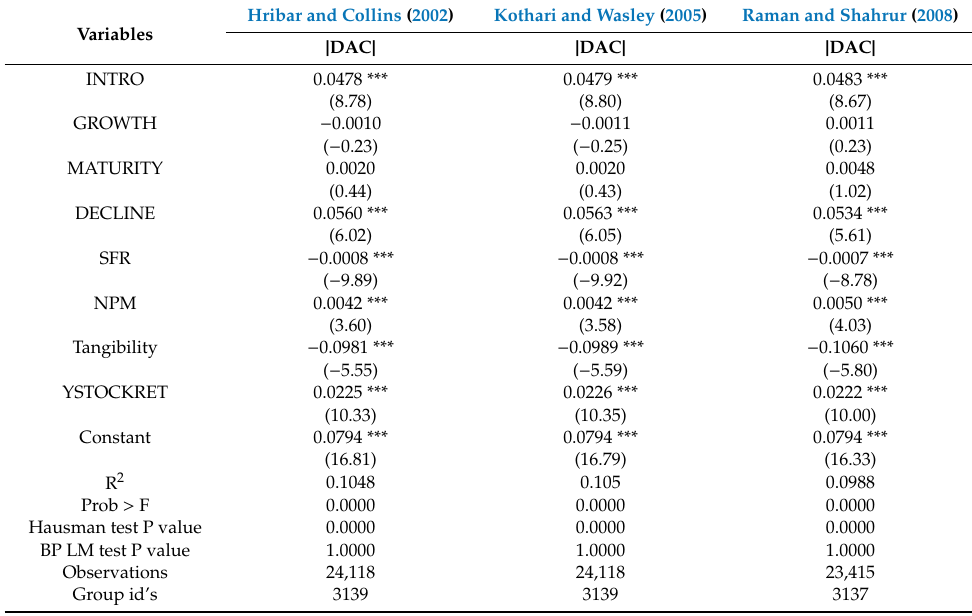
Table 6. H1 Estimations (CLC Stages and AEM